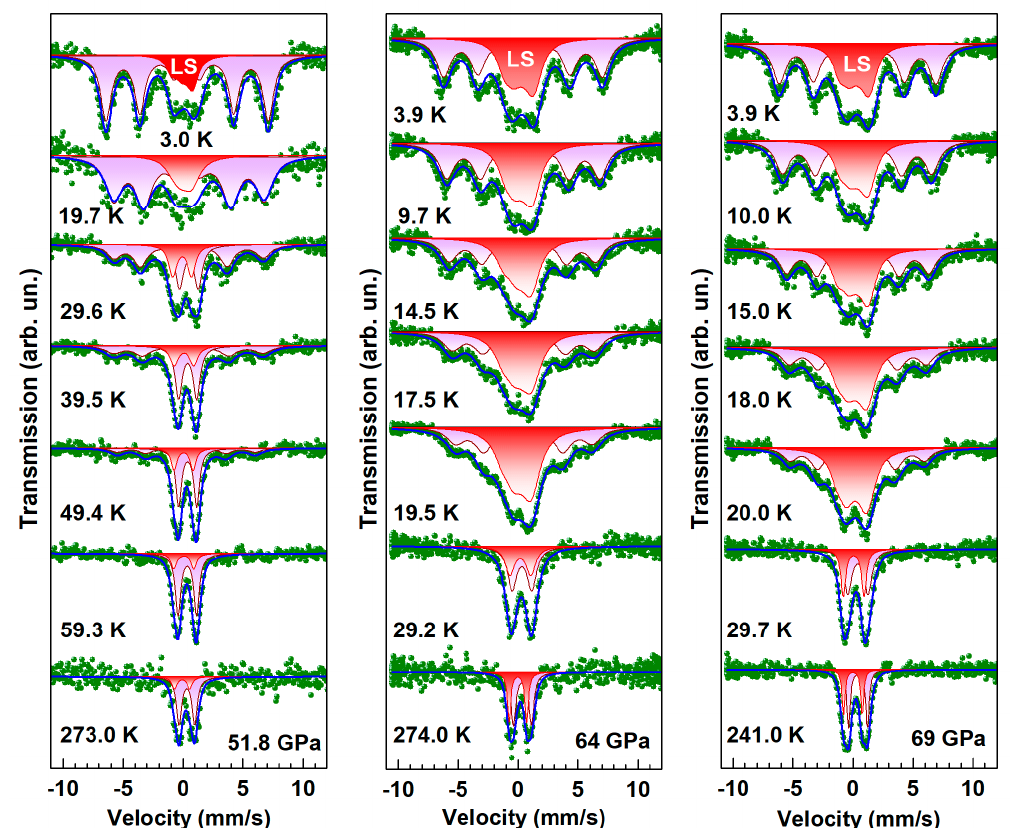
Figure 10. (Colour on-line) Evolution of SMS spectra with temperature in Ba 3 NbFe 3 Si 2 O 14 at pressure of 51.8, 64.0 and 69.0 GPa. Color lines are the calculated subspectra fitted to the experimental points (dots). The LS sign indicates the Mössbauer subspectrum corresponding to iron ions in the low-spin state.